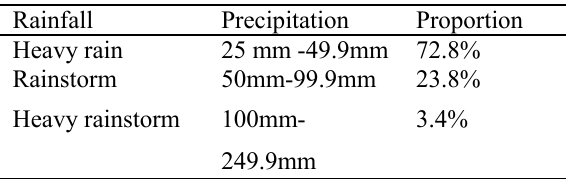
Table 2. Precipitation statistics from January 2008 to